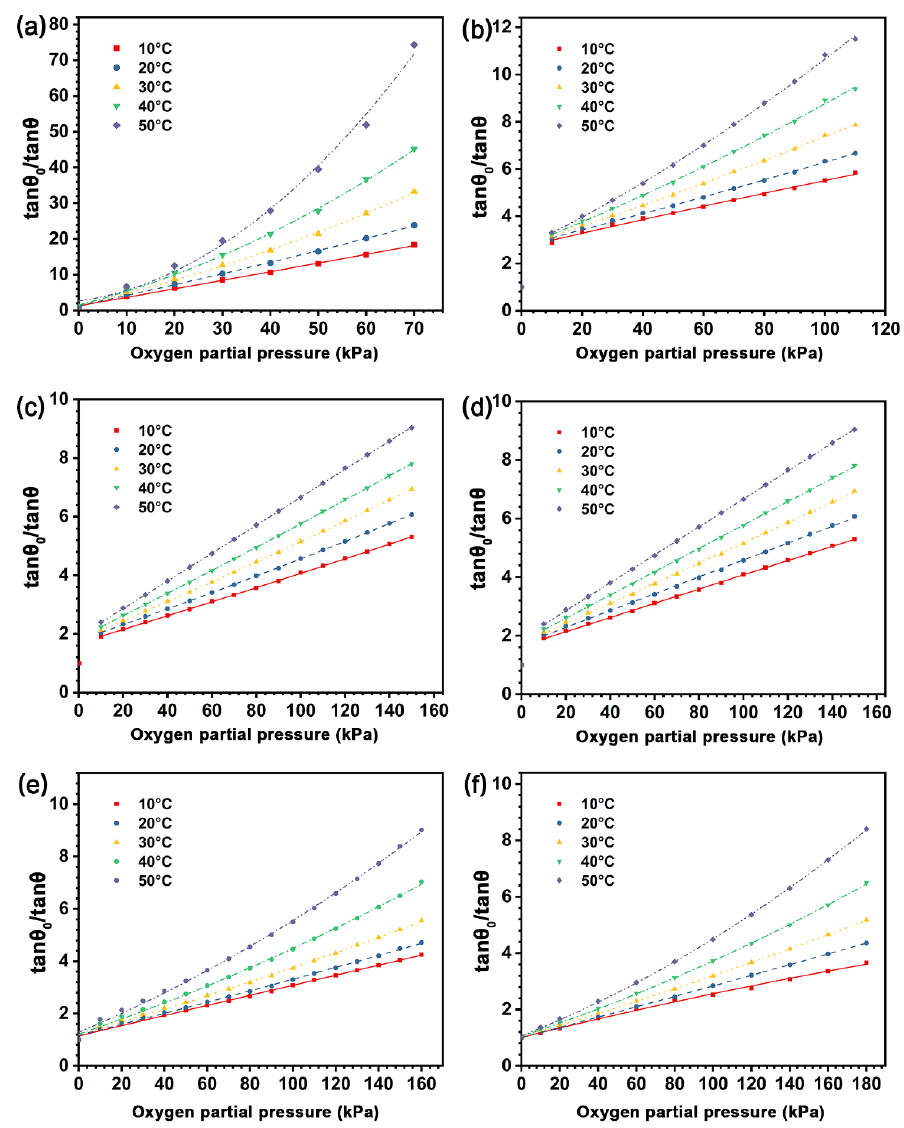
Figure 9. Stern-Volmer plots of the sensing films with different polymer matrices of ( a ) SF-EC; ( b ) SF-E3P1 (EC/PMMA ratio of 3:1); ( c ) SF-E1P1 (EC/PMMA ratio of 1:1); ( d ) linear fitting of SF-E1P1; ( e ) SF-E1P3 (EC/PMMA ratio of 1:3); ( f ) SF-PMMA from 10 °C to 50 °C. Except for ( d ), fitting formulas are quadratic polynomials and R 2 > 0.99.